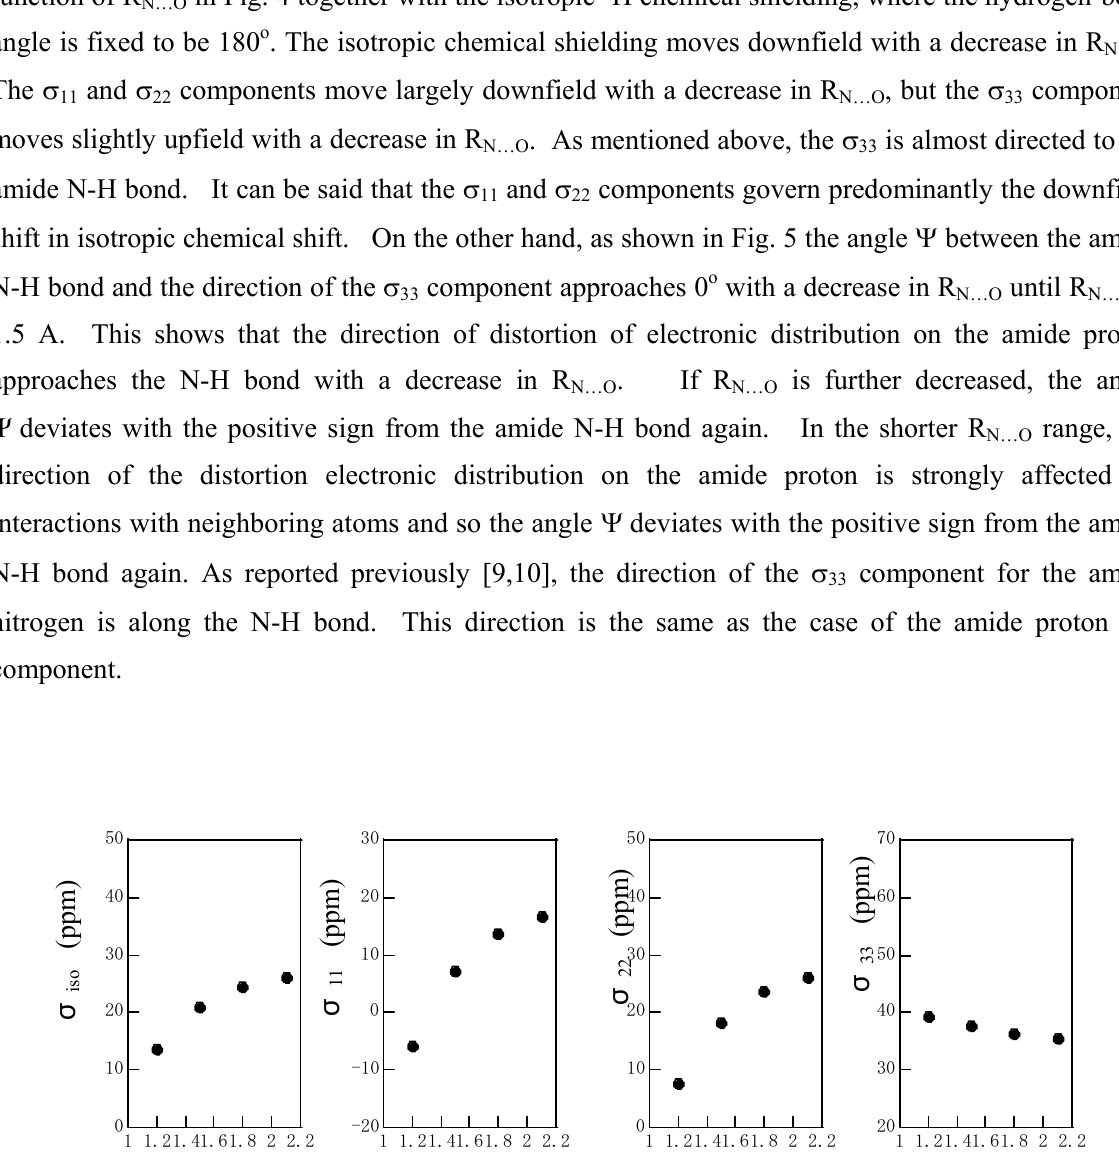
Figure 4. The plots of the calculated isotropic 1 H chemical shielding σ shielding tensor components σ hydrogen-bonded with a formamide against R to be 180 o